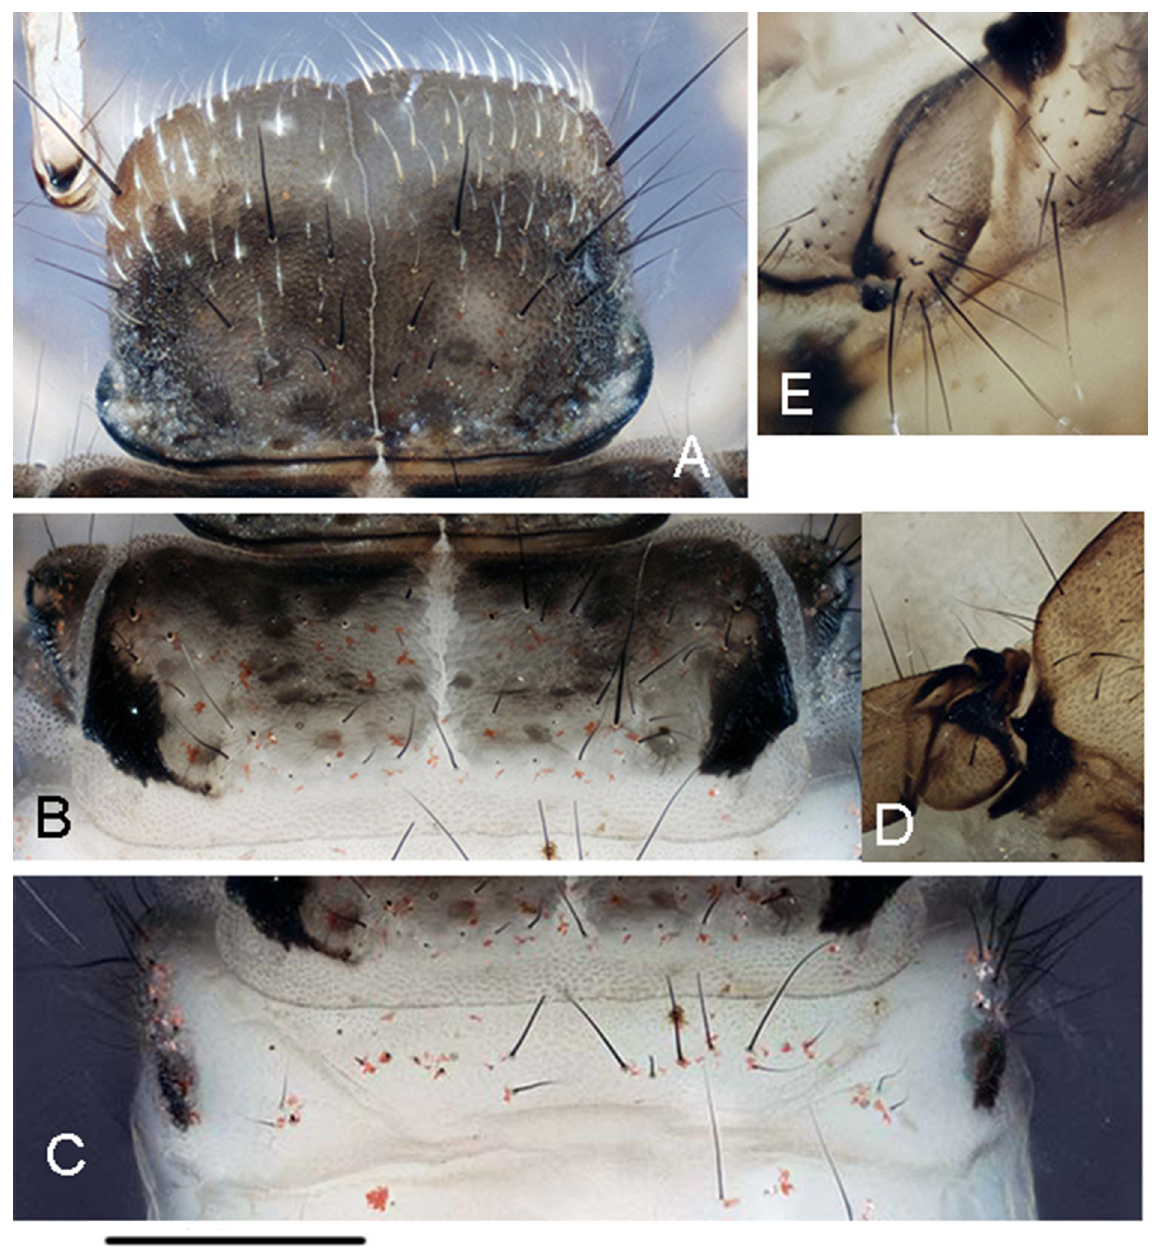
Fig. 10. Thorax of Apatidelia acuminata Leng & Yang, 1998, larva. A . Pronotum (dorsal view). B . Mesonotum (dorsal view). C . Metanotum (dorsal view). D . Foretrochantin (lateral view). E . Mesopleura (lateral view). Scale bar = 0.5